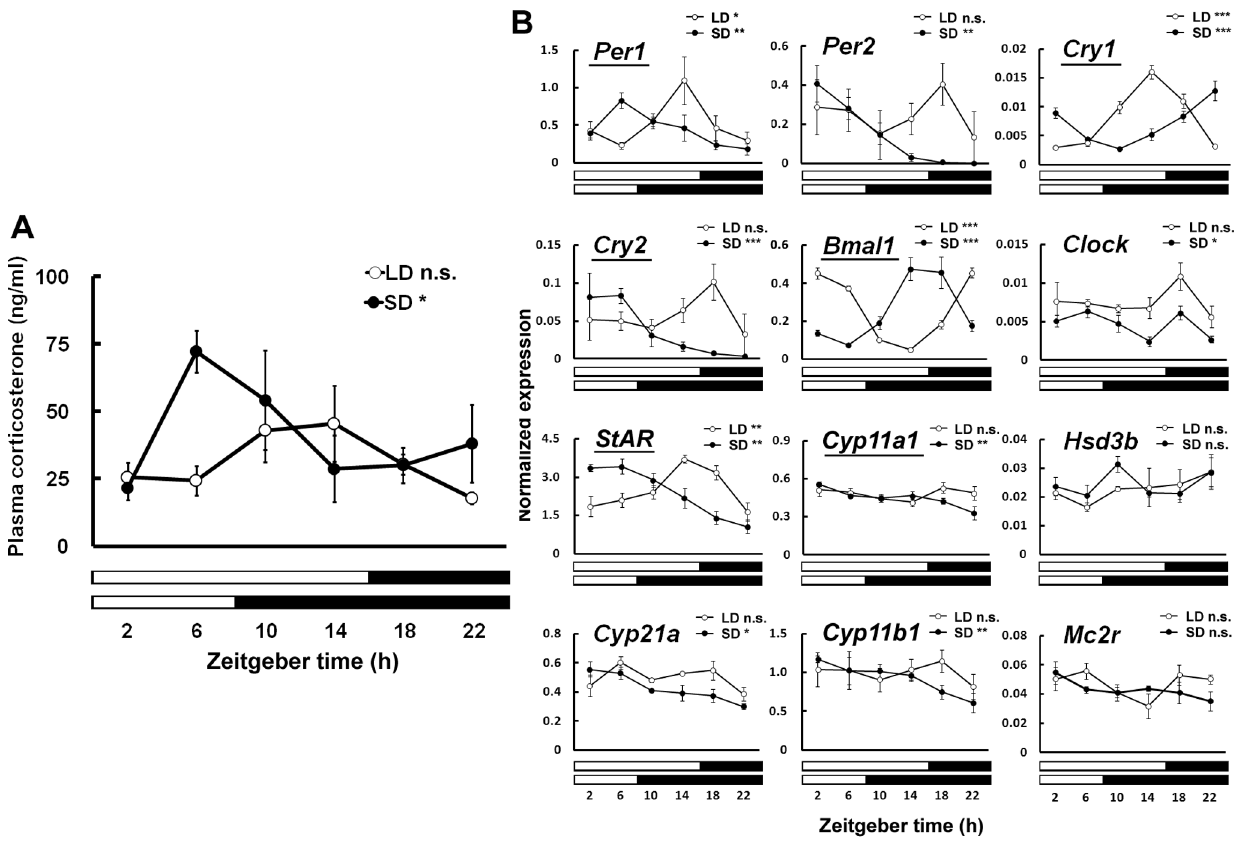
Figure 5. Effects of photoperiod on plasma corticosterone rhythms and expression of adrenal genes in C57BL/6J mice. Mice were maintained under either short-day condition (SD, 8 h of light, 16 h of darkness, black circles ) or long-day condition (LD, 16 h of light, 8 h of darkness, white circles ) for 2 weeks, and examined diurnal rhythms of plasma corticosterone (A) and expression of clock genes and steroidgenesis genes (B). Diurnal rhythmicity was analyzed by one-way ANOVA, and significances (*, P , 0.05, **, P , 0.01, ***, P , 0.001) or non-significances (n.s.) were indicated in each graph. Significant effects of photoperiod on the expression profiles of adrenal genes were indicated by underlines of gene symbols (two-way ANOVA, interactions between photoperiod and time, P , 0.05). Values are means 6 SEM (n=4–10).